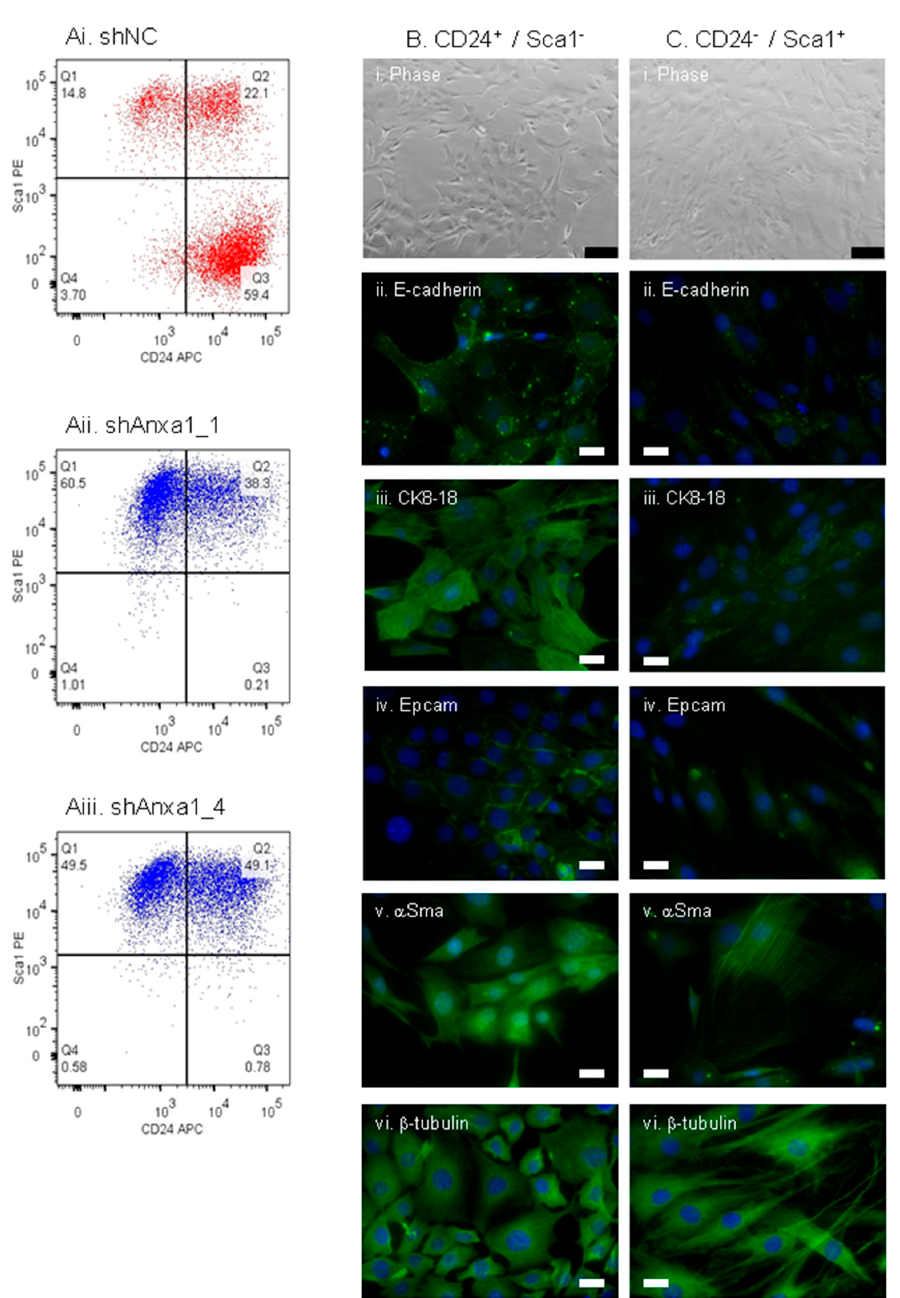
Figure 8. Expression of markers of tumor-initiating cells in control and Annexin-A1-depleted PyMTneoLUC cells. ( A ) ( i ) Control PyMTneoLUC_shNC, ( ii ) PyMTneoLUC_shAnxa1_1, and ( iii ) PyMTneoLUC_shAnxa1_4 cultured cell lines were analyzed by flow cytometry for Sca1 and CD24 cell surface expression. ( B , C ) Morphology and marker expression of sorted PyMT cells. Parental PyMT cells were sorted into CD24 + /Sca1 − ( B ) and CD24 − /Sca1 + ( C ) populations and cultured on collagen-coated slides for 6 days prior to assessment of morphology and marker expression by immunofluorescence. ( i ) Phase contrast microscopy. Scale bar 500 µ m. ( ii ) E-cadherin. ( iii ) Cytokeratin 8–18. ( iv ) Epcam. ( v ) Alpha smooth muscle actin ( α Sma). ( vi ) β -tubulin. White scale bars represent 20 µ